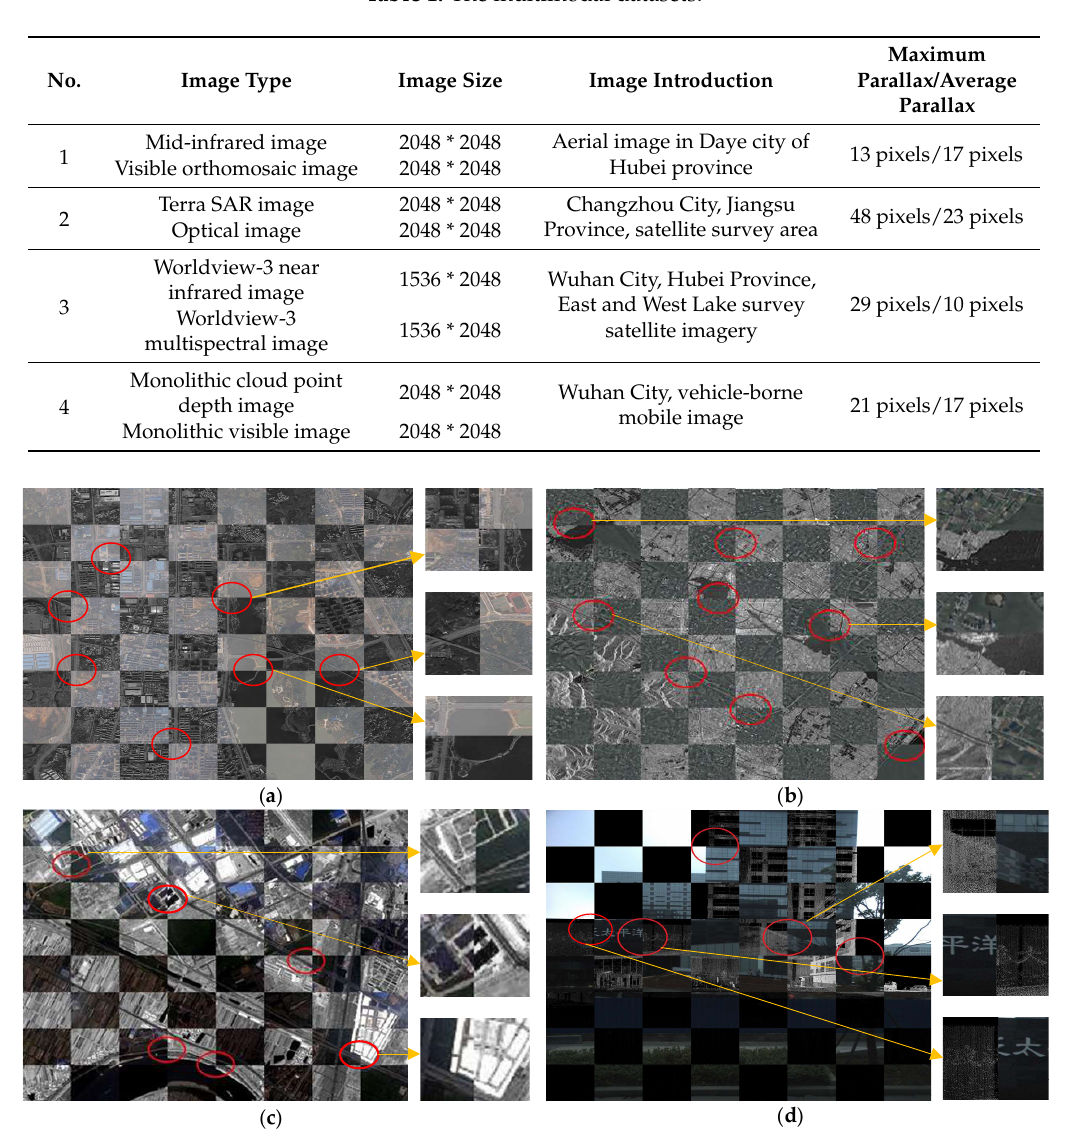
Figure 4. Checkerboard visualization results and local graphs of multimodal images before registration. The images were superimposed together, in the form of alternate checkerboard before registration. Red circles demonstrate the non-aligned area of the checkerboard block edge. For each group of multimodal images, three non-aligned areas were chosen for local amplification. The above row illustrates the raw unregistered image data: ( a ) Mid-infrared image and visible orthomosaic image; ( b ) Terra SAR image and optical image; ( c ) Worldview-3 near infrared image and multispectral image; ( d ) Monolithic cloud point depth image and visible image.